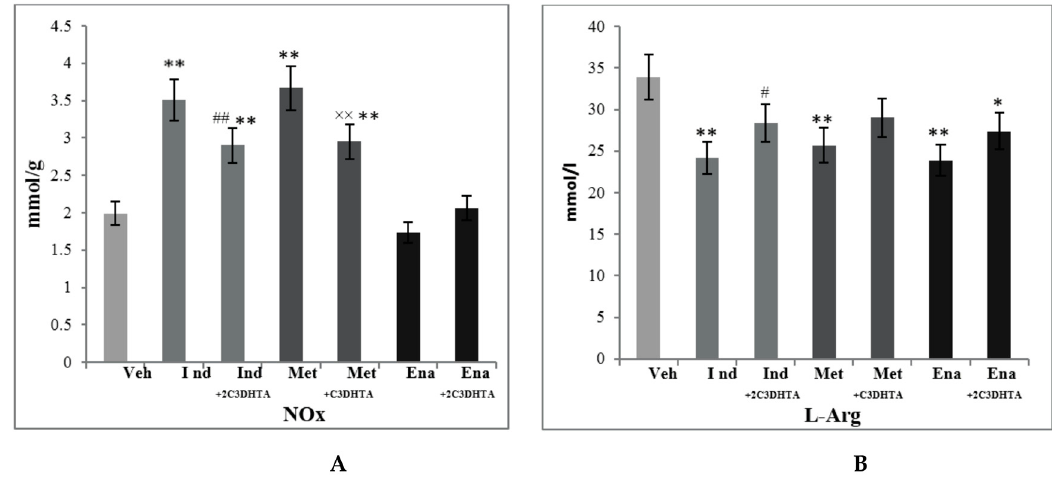
Figure 5. Concentrations of stable products of NO in homogenates of small intestinal mucosa ( A ) and the level of L -Arginine ( L -Arg) in blood serum ( B ) at the background of drug-induced enteropathy of rats of the following groups: group 1—control group (Veh), group